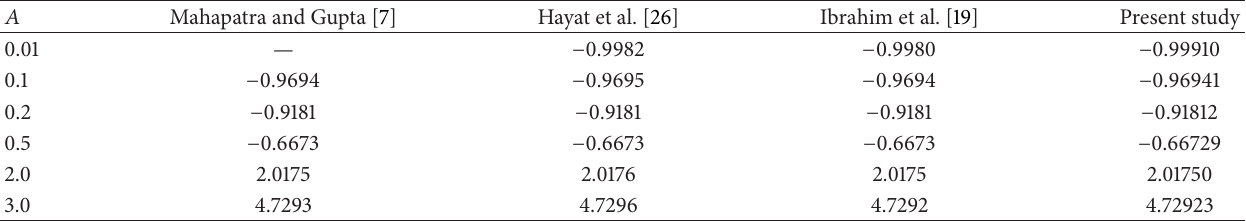
Table 1: Comparison of the values of skin friction coefficient 𝑓 󸀠󸀠 (0) for various values of velocity ratio 𝐴 .